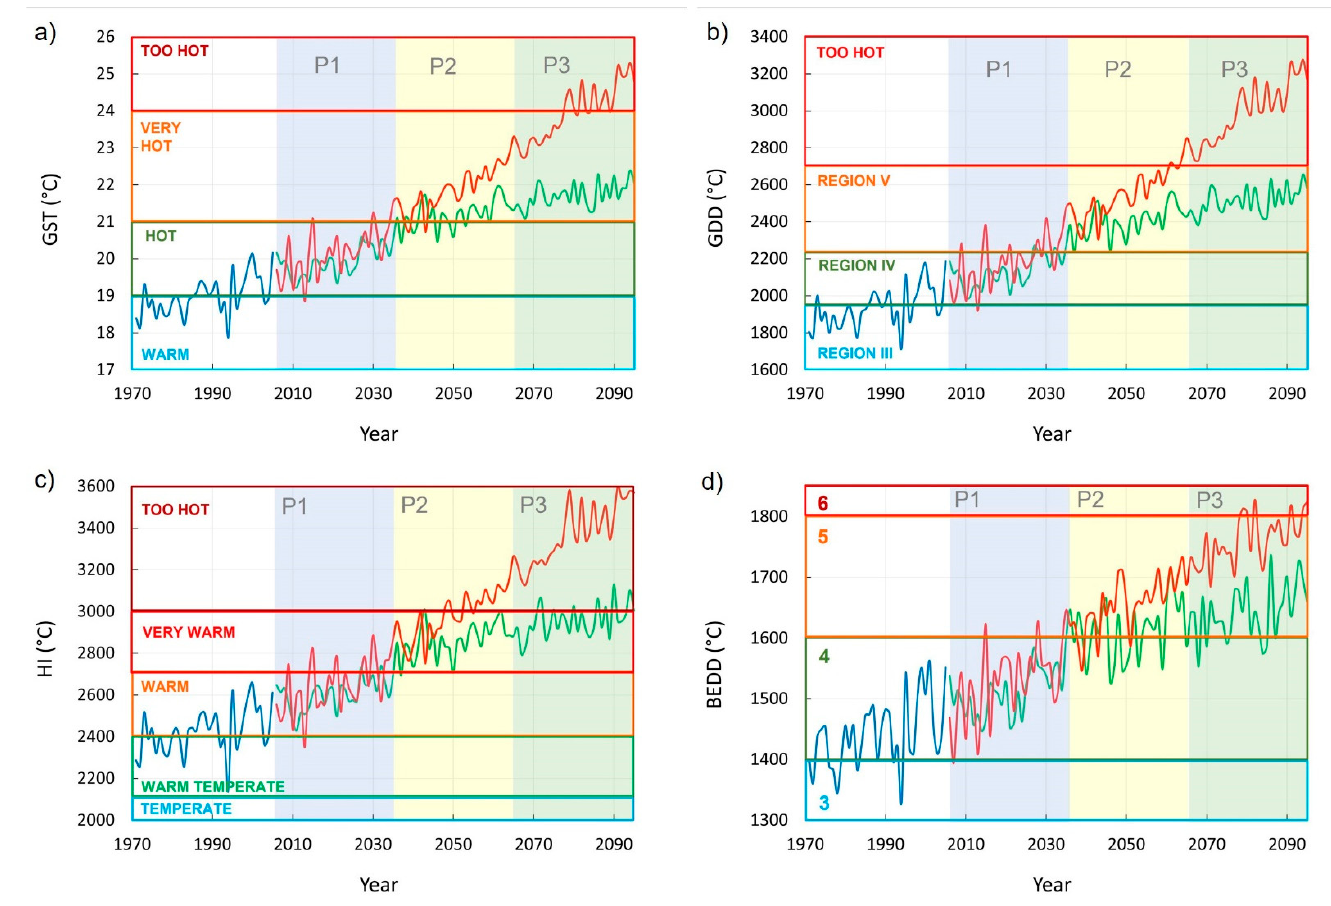
Figure 3. Temporal evolution of GST ( a ), GDD ( b ), HI ( c ) and BEDD ( d ) during the historical period (blue line) and the future time periods considered in the study, under the RCP 4.5 (green line) and RCP 8.5 (red line) scenarios. Table 4. Statistics of the Mann-Kendall test (ZMK) and the magnitude of trends approximated by Sen’s estimator ( β ) for each bioclimatic index, considering the historical period and all years until the end of the 21st century for each scenario. RC is the relative change.